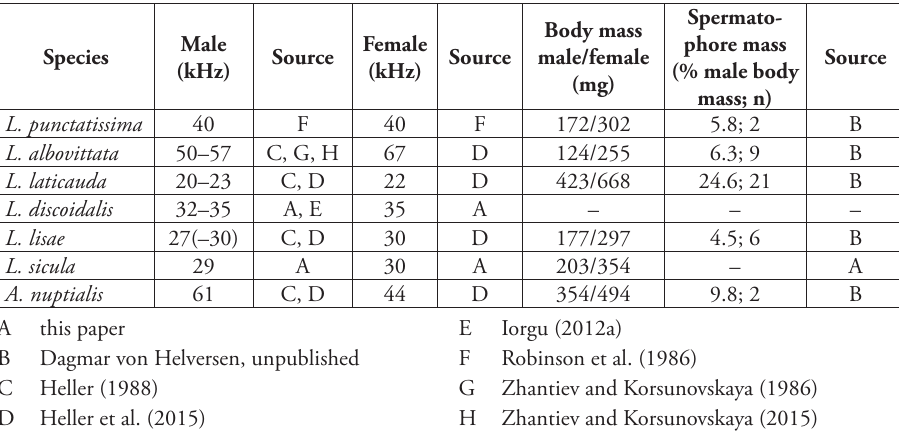
Table 1. Peak frequencies of male and female song and body and spermatophore mass in European Leptophyes and Andreiniimon